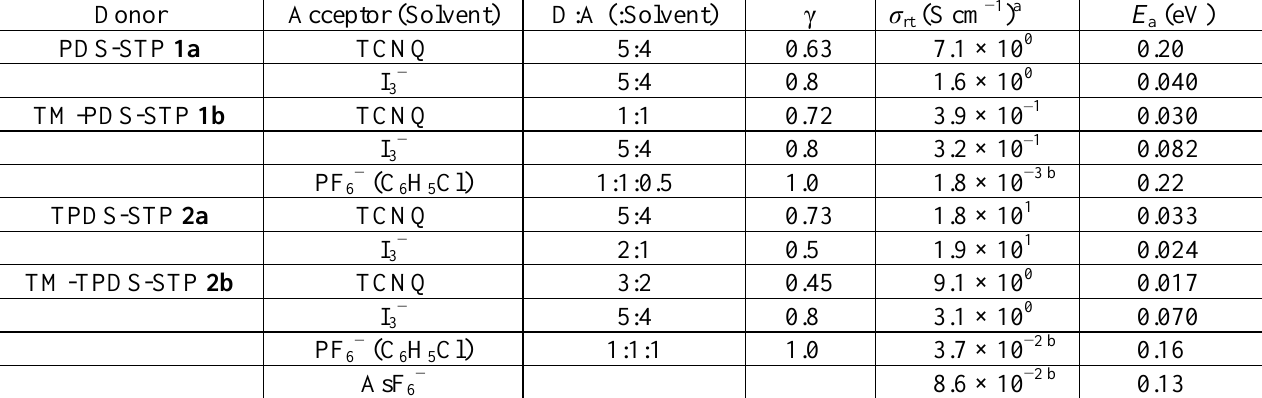
Table 2. Electrical properties of conducting materials based on 1 and 2